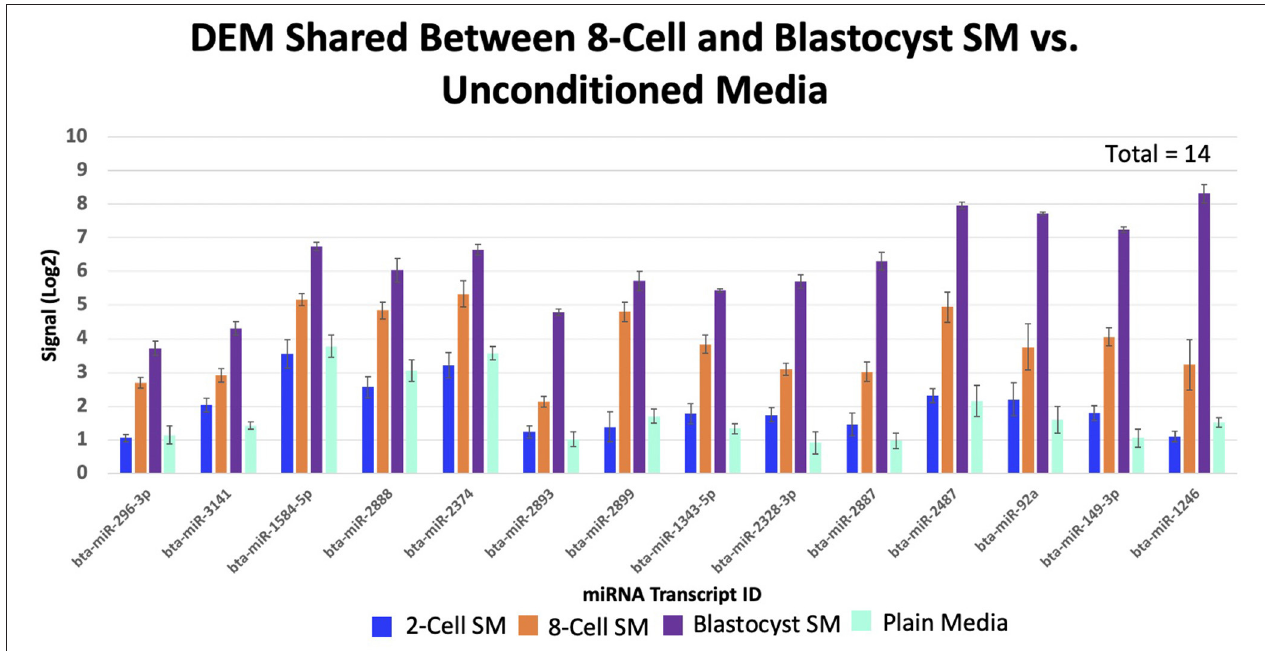
FIGURE 5 | Fourteen miRNAs were significantly shared between 8-cell and blastocyst spent media. All miRNAs increased in levels of up-regulation from the 8-cell to the blastocyst spent media.